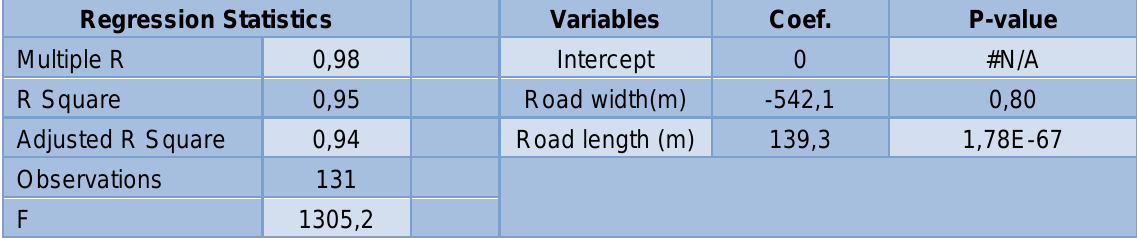
Table 14 Multiple regression results among total project cost and road length and width when intercept = 0